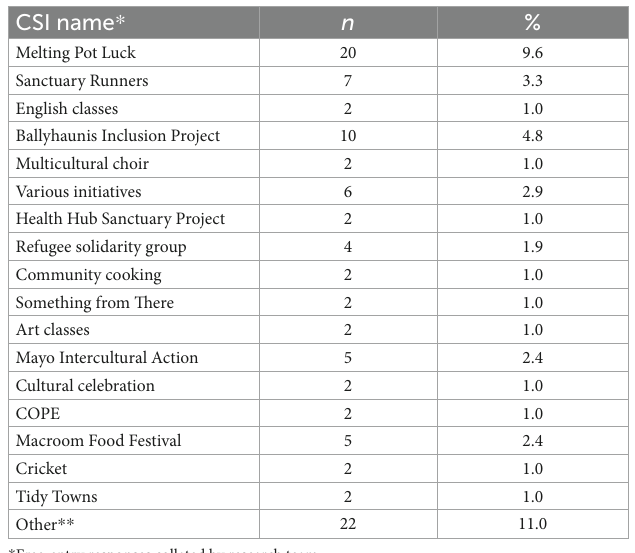
TABLE 1 Sample demographic characteristics. TABLE 2 Community solidarity initiatives.